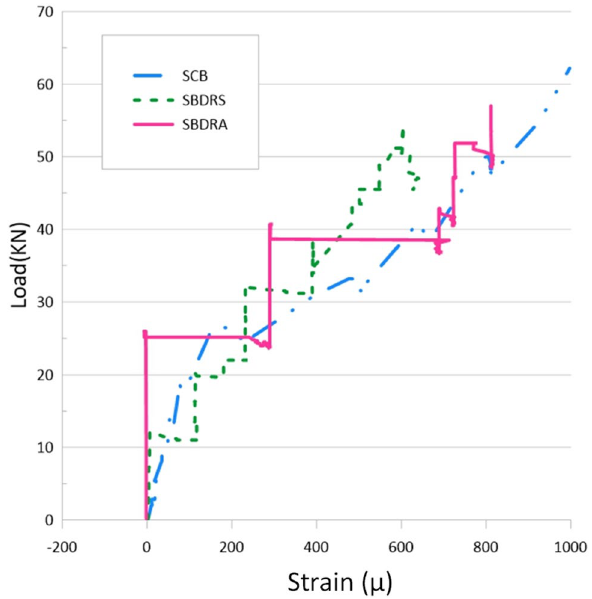
Fig. 14 Load–strain curves for two specimens compared to those of the control